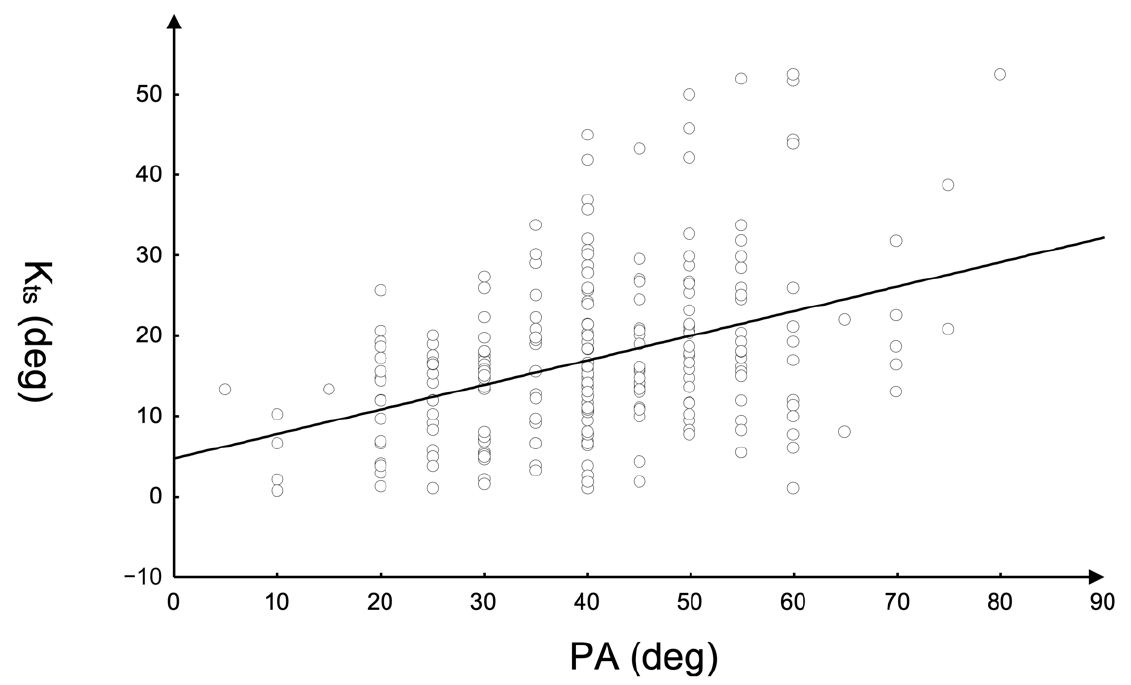
Figure 3. Knee position at the end of swing/initial stance (K ts ) increases with the popliteal angle (PA) according to the equation: K ts = 5.00 + 0.31 × PA (r = 0.39; p < 0.001) in the limbs of patients with CP. Each circle represents the K ts value for the specific PA angle acquired from one single study participant.